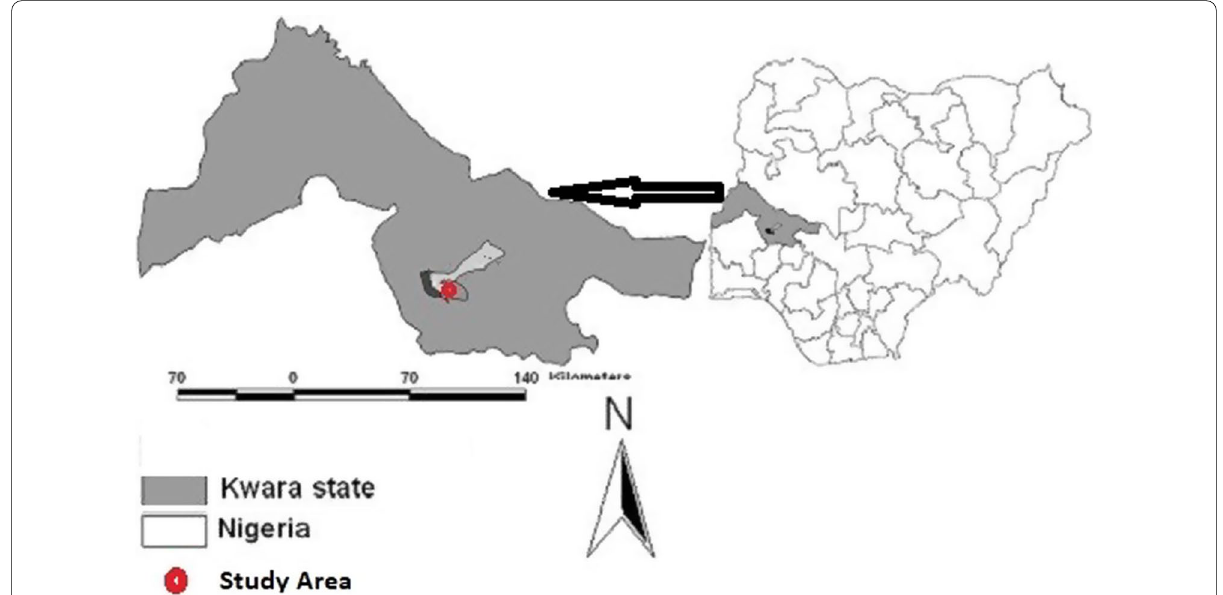
Fig. 1 Map of Nigeria and Kwara State and the location of study